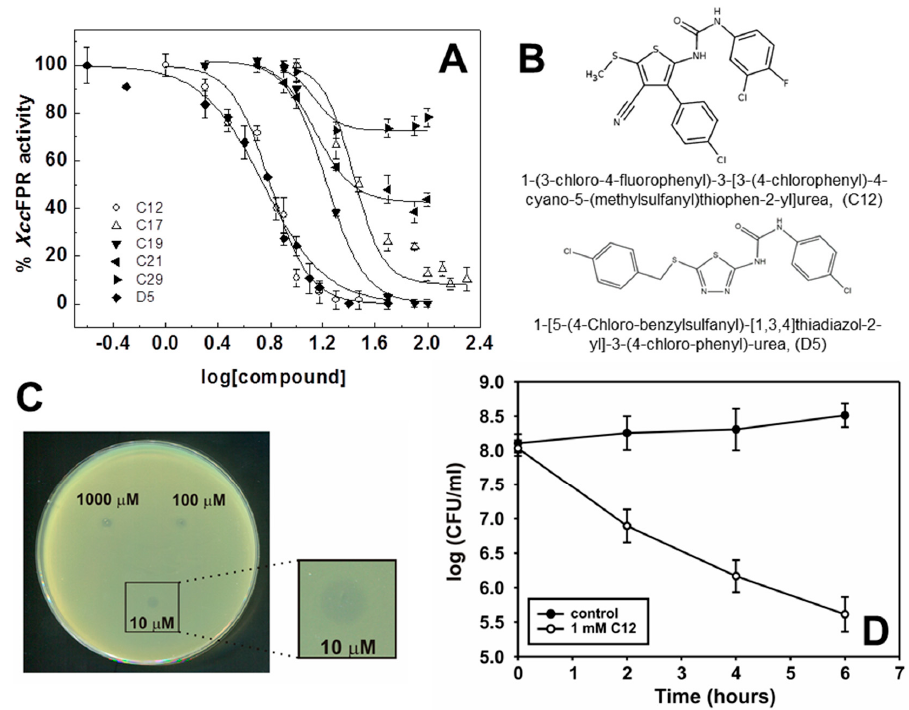
Figure 3. Best performing inhibitors. ( A ) Dose-response curves for the Xcc FPR 2,6-dichlorophenolindophenol (DCPIP)-diaphorase activity in the presence of representative hits. Values derived from these representations are included in Tables 1 and 2. Experiments performed at 25 °C in a mixture containing 20 nM Xcc FPR, 95 μ M DCPIP and 50 μ M NADPH in 50 mM Tris/HCl pH 8.0 ( n > 3, mean ± SD). ( B ) Chemical structures of C12 and D5. ( C ) Xcc growth inhibition in SB-agar plates with different concentrations (1000, 100 and 10 μ M) of C12. The zones of growth inhibition were photographed after incubation for 24 h at 28 °C. ( D ) Liquid SB growth in the presence of 1 mM C12. Xcc culture was cultivated aerobically in SB medium at 28 °C with shaking at 200 r.p.m. Aliquots were taken at the indicated times and measured for colony-forming capacity on SB-agar plates ( n > 3, mean ± SD). Control: 2% DMSO.